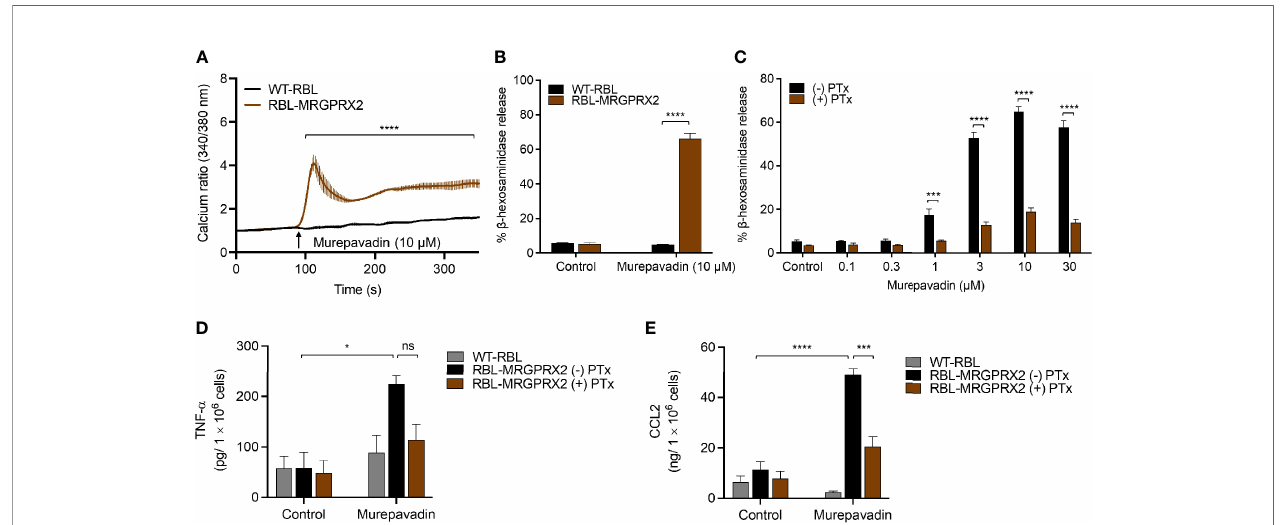
FIGURE 2 | Murepavadin induces intracellular Ca 2+ mobilization, degranulation and chemokine production in MCs through MRGPRX2. (A) Calcium mobilization measurement following murepavadin (10 m M) stimulation of Fura-2 loaded WT-RBL and RBL-MRGPRX2 cells. (B) WT-RBL and RBL-MRGPRX2 cells were exposed to 10 m M murepavadin (30 min), and degranulation was assayed by measuring the release of b -hexosaminidase. (C) RBL-MRGPRX2 cells were incubated in the presence or absence of pertussis toxin (PTx), at a concentration of 100 ng/mL for 16 h and exposed to indicated concentrations of murepavadin (30 min) and degranulation was assayed by measuring the release of b -hexosaminidase. (D, E) WT-RBL and RBL-MRGPRX2 cells were incubated in the presence or absence of pertussis toxin (PTx) at a concentration of 100 ng/mL for 16 h and exposed to 10 m M of murepavadin (24 h) and the production of cytokine TNF- a and chemokine CCL2 were quanti fi ed by ELISA. Data presented are the mean ± SEM of at least three experiments. Statistical signi fi cance was determined by two-way ANOVA with S ̌ ı ́ da ́ k ’ s or Tukey ’ s multiple comparisons at a value * p < 0.05, *** p < 0.001, **** p < 0.0001, and ns denotes “ not signi fi cant ”